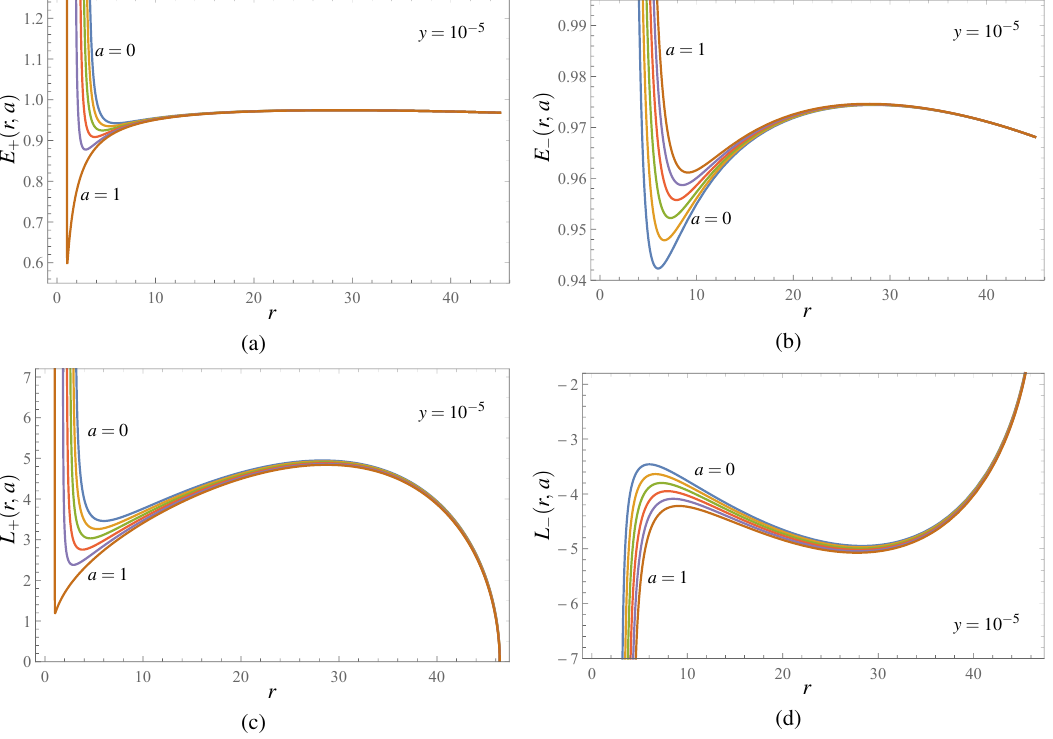
Figure 3. Specific energy and specific angular momentum of the equatorial circular orbits of Kerr–de Sitter black-hole spacetimes. The spacetimes are specified by the cosmological parameter y = 10 − 5 and the rotational parameter a varying from 0 to 1 in steps of 0.2. The left column corresponds to the plus-family orbits, the right column corresponds to the minus-family orbits. The local extrema of the curves correspond to the marginally stable